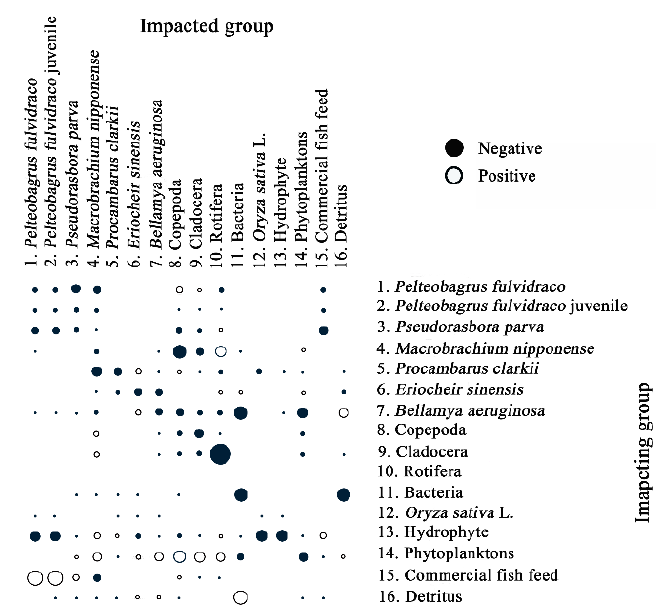
Figure 5. A mixed trophic impact analysis in the FMRP.